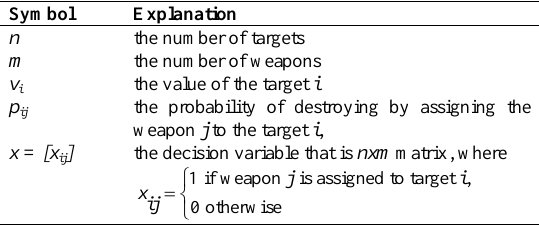
Table 1. Definition of symbols for the WTA model.